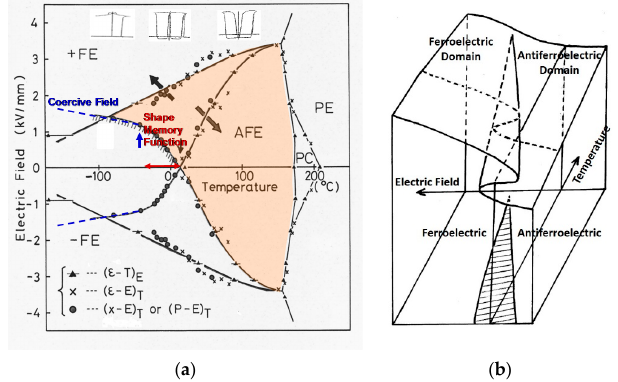
Figure 9. ( a ) Phase diagram on the temperature-bias electric field plane for Pb 0.99 Nb 0.02 [(Zr 0.6 Sn 0.4 ) 0.94 Ti 0.06 ] 0.98 O 3 ). ( b ) Schematic 3D view for improved understanding of the Antiferroelectric – Ferroelectric (AFE-FE) transformation hysteresis.